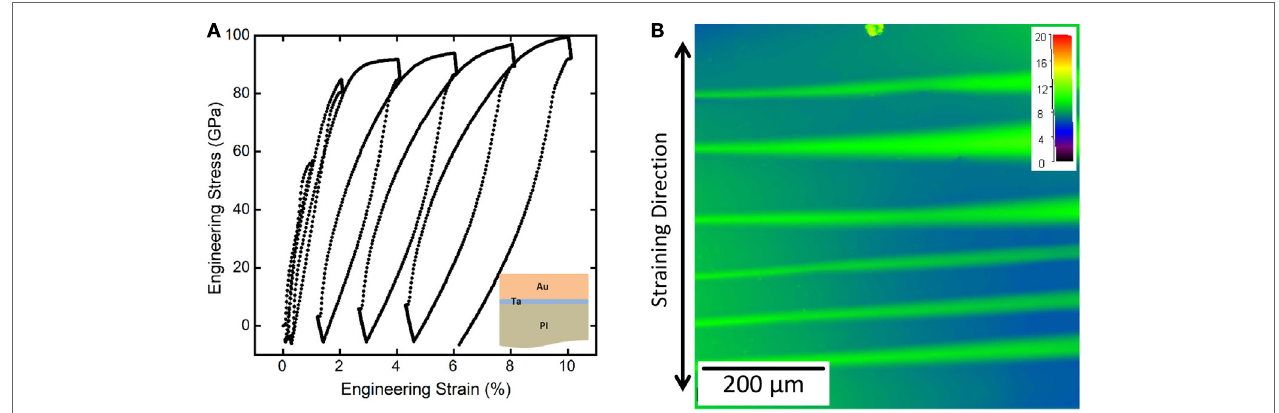
FigUre 7 | (a) Tensile loading curve of a 300-nm Au film with a 10-nm Ta adhesion layer on PI. (B) When the load was removed (decreased to 0 N) buckles form perpendicular to the straining direction and can be used to calculate the adhesion energy of the